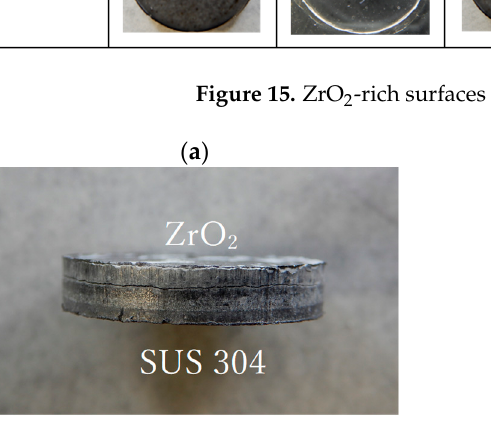
Figure 16. 3-layered ( a ) and 2-layered ( b ) samples just after SPS.